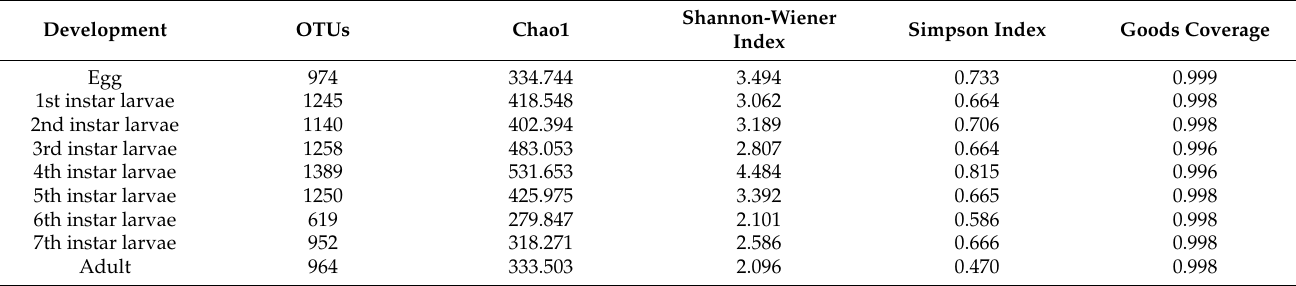
Table A2. The α diversity index values of the gut microbiota of L. xylina samples fed on SAC and NSC, calculated at the same level, 97%.